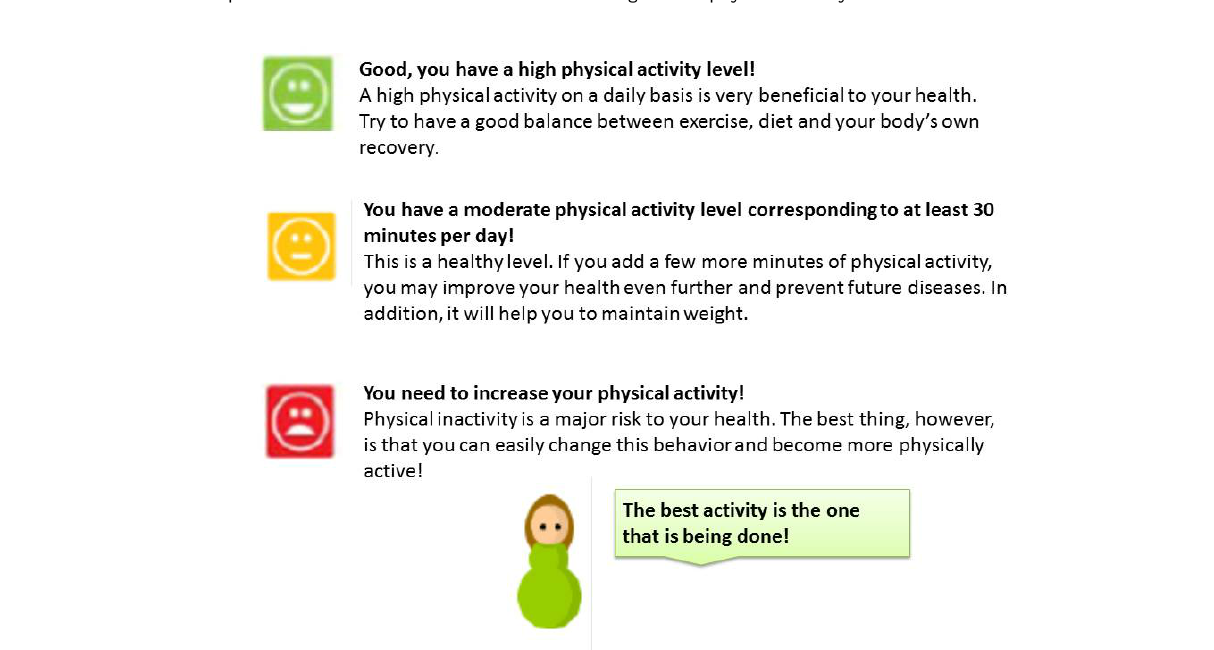
Figure 2. Screenshot of examples of the tailored web-based health feedback given for physical